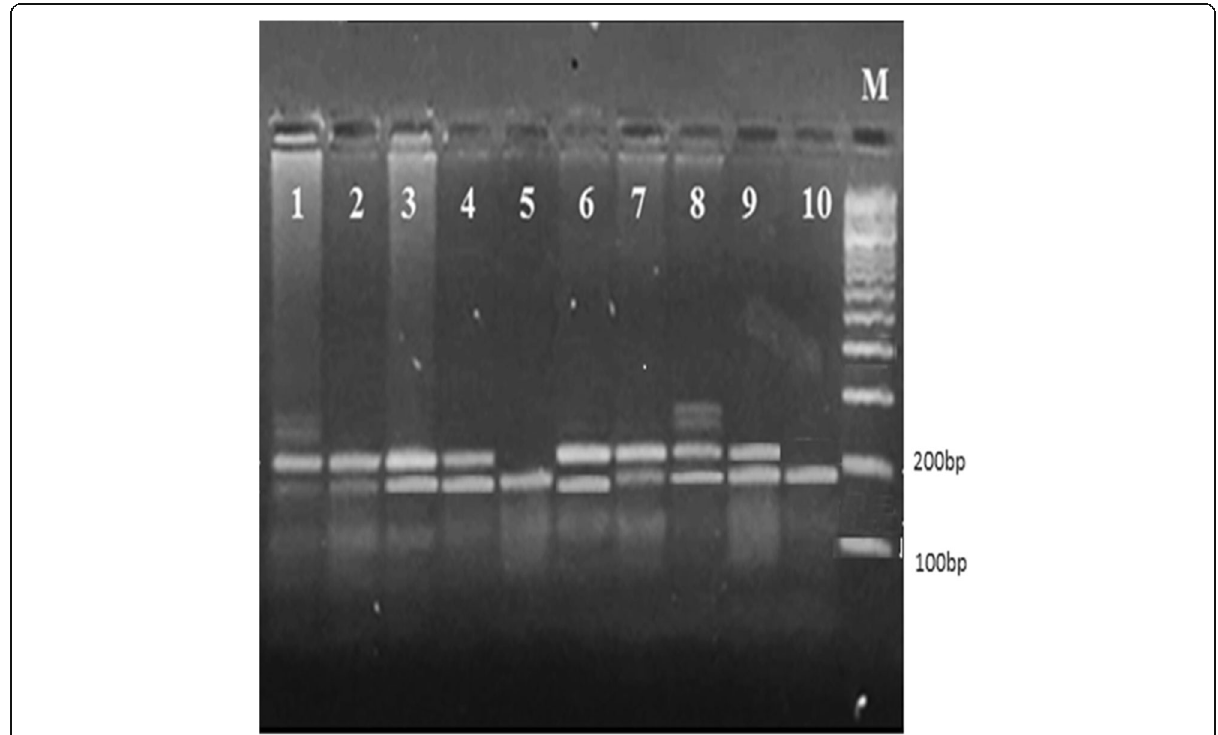
Fig. 1 Agarose gel electrophoresis of TNFAIP3 ( rs5029939 C>G ) SNP PCR products. Enzyme digestion products of TNFAIP3 rs5029939 (C>G) SNP using AFLII restriction enzyme. Lanes 1, 2, 3, 4, 6, 7, 8, and 9: mutant heterozygous genotype (CG); lanes 5 and 10: wild homozygous genotype (CC). M, DNA marker Ladder